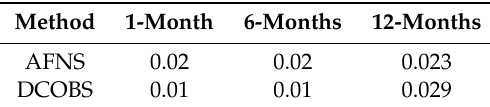
Table 2. Forecast root mean square errors.